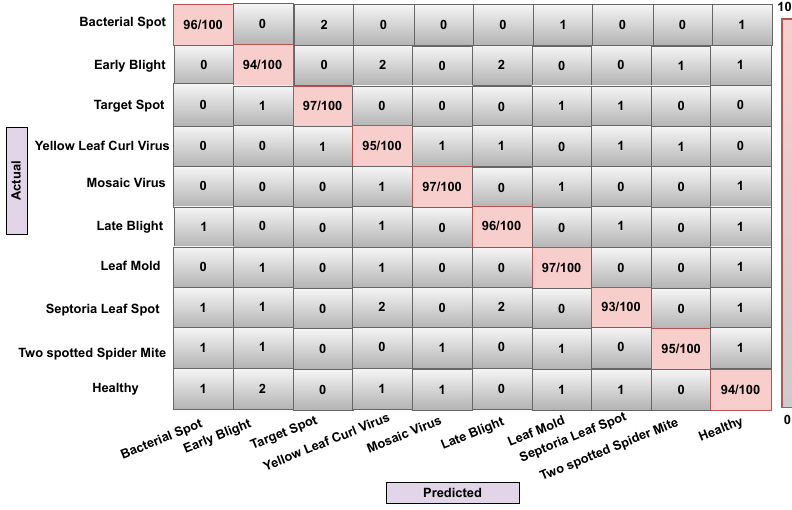
Figure 13. Confusion matrix of CNN-LR method during testing.